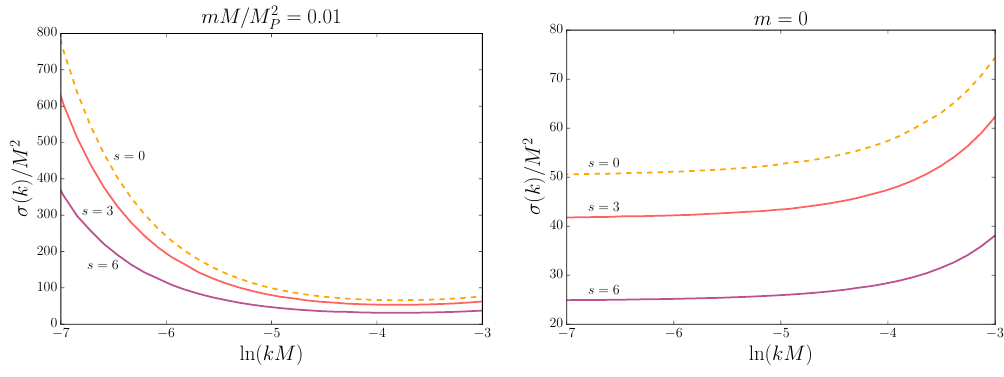
Figure 1 . Cross-section (cid:27) against momentum k , for three choices of s = c=M 3 . On the left is (cid:27) in the low-mass regime, and on the right is the massless cross-section. One sees that the tidal terms reduce the value of the cross-section by a factor independent of momentum k . One also observes the 1 =k 2 asymptotic dependence of the massive cross-section, in contrast to the constant limiting value of the massless cross-section.